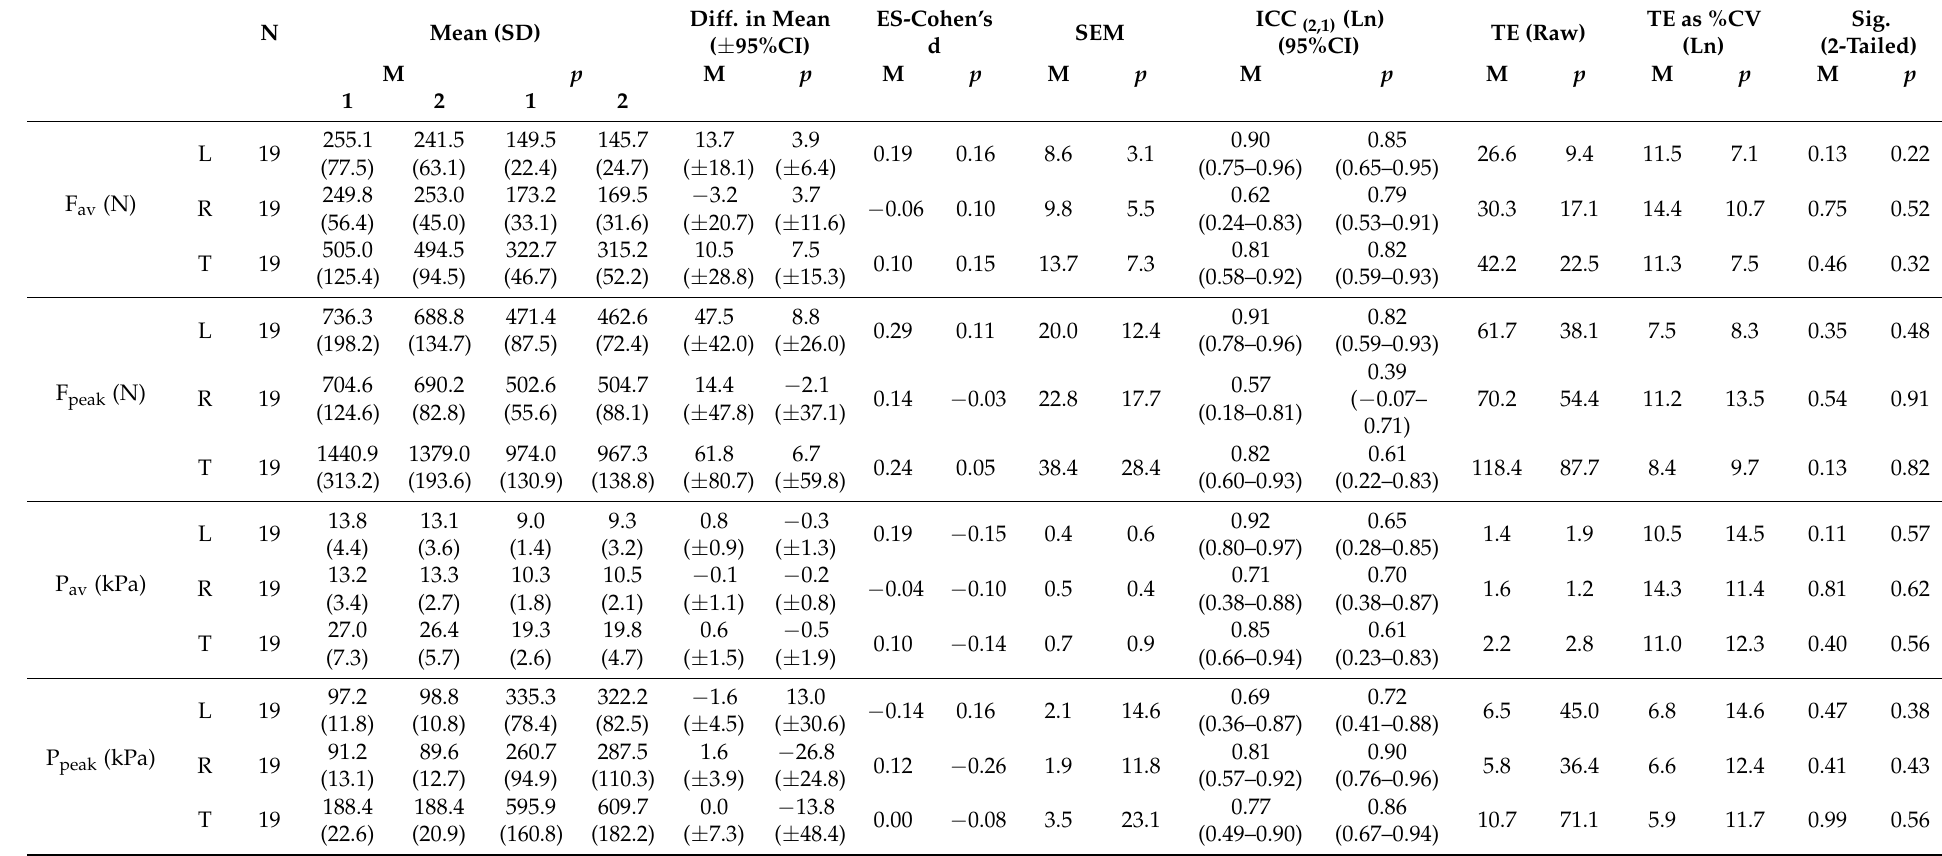
Table 1. Reliability of Moticon and Pedar-x insoles for plantar pressure and reaction force